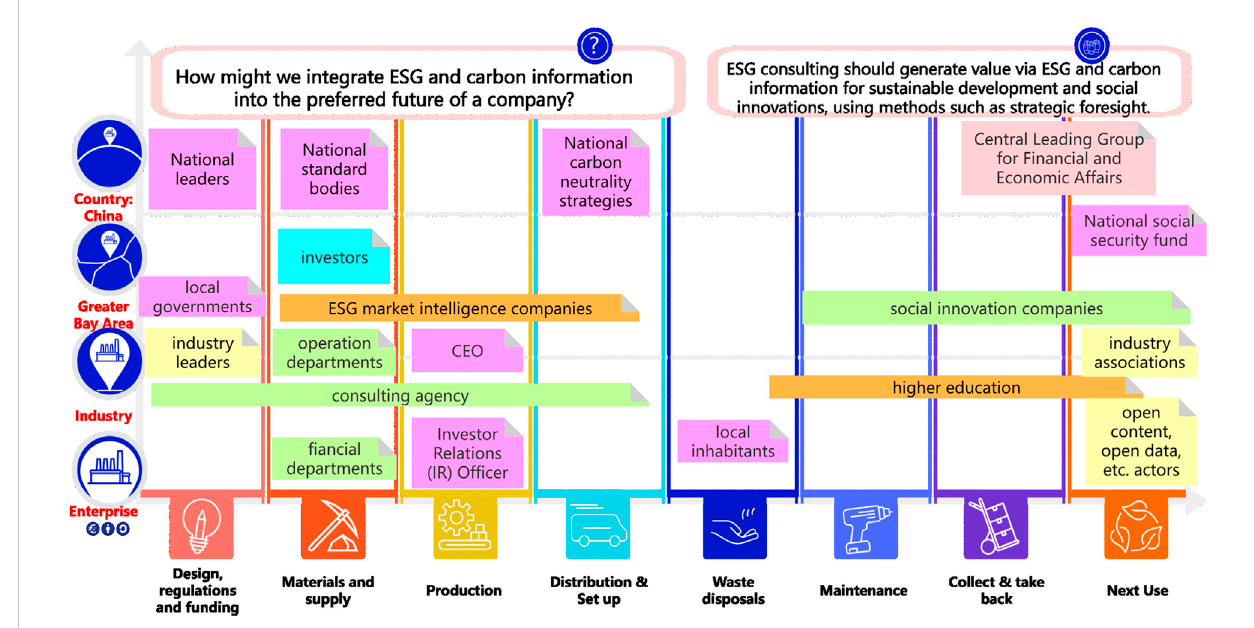
FIGURE 1 Partner map for ESG consulting (based on the blank canvas provided by Circulab (2020) through Creative Commons License Attribution- NonCommercial-ShareAlike 4.0